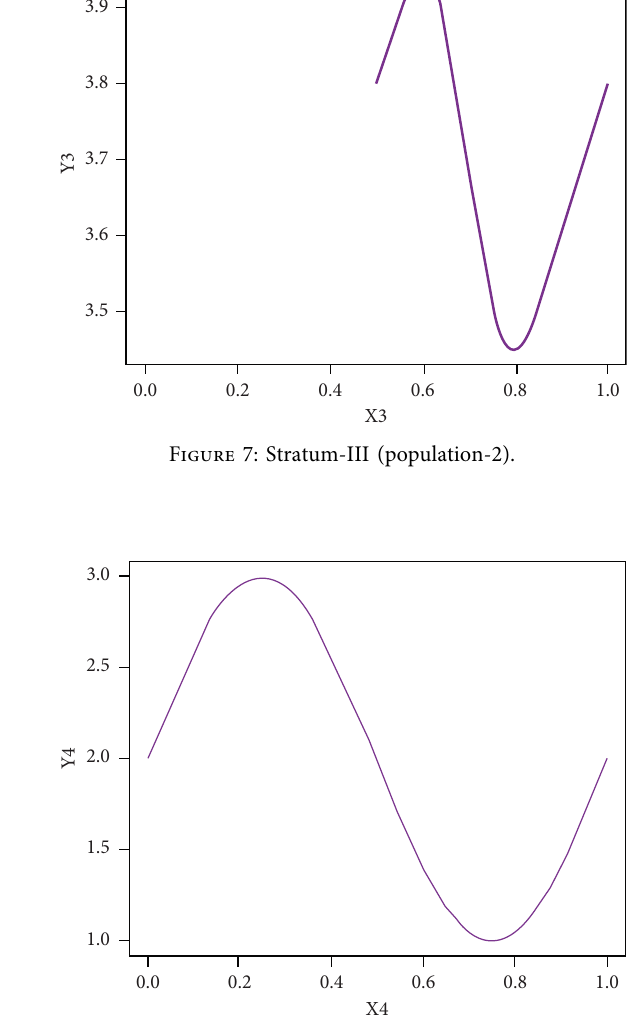
Figure 8: Stratum-IV